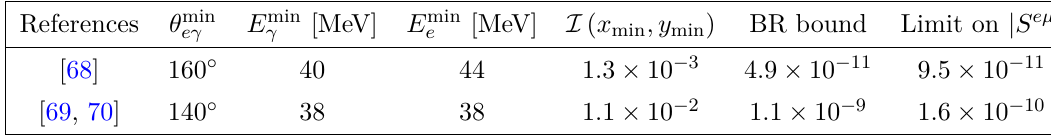
Table 1 . Results in the search for µ → e γ φ at the Crystal Box